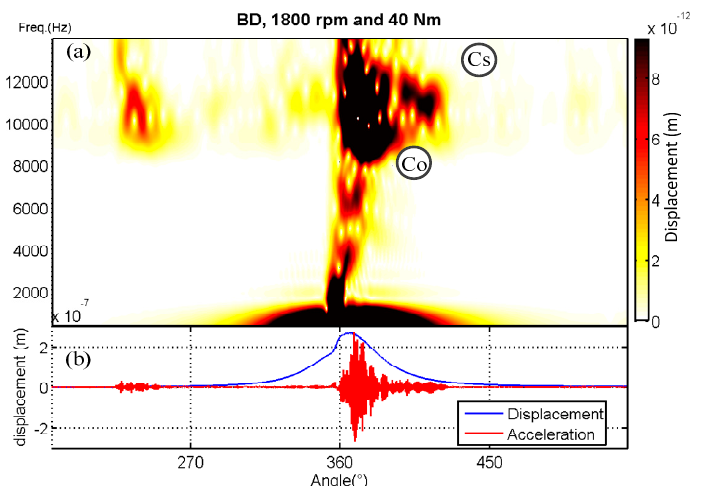
Figure 12. The Short-time Fourier transform (STFT) of dynamic responses to the combustion of biodiesel, 1800/40 (m); ( a ) STFT result of predicted displacement response; ( b ) Predicted displacement and acceleration responses.